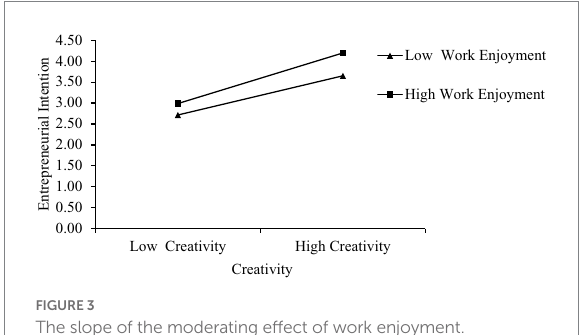
FIGURE 5 The slope of the moderating effect of intrinsic work